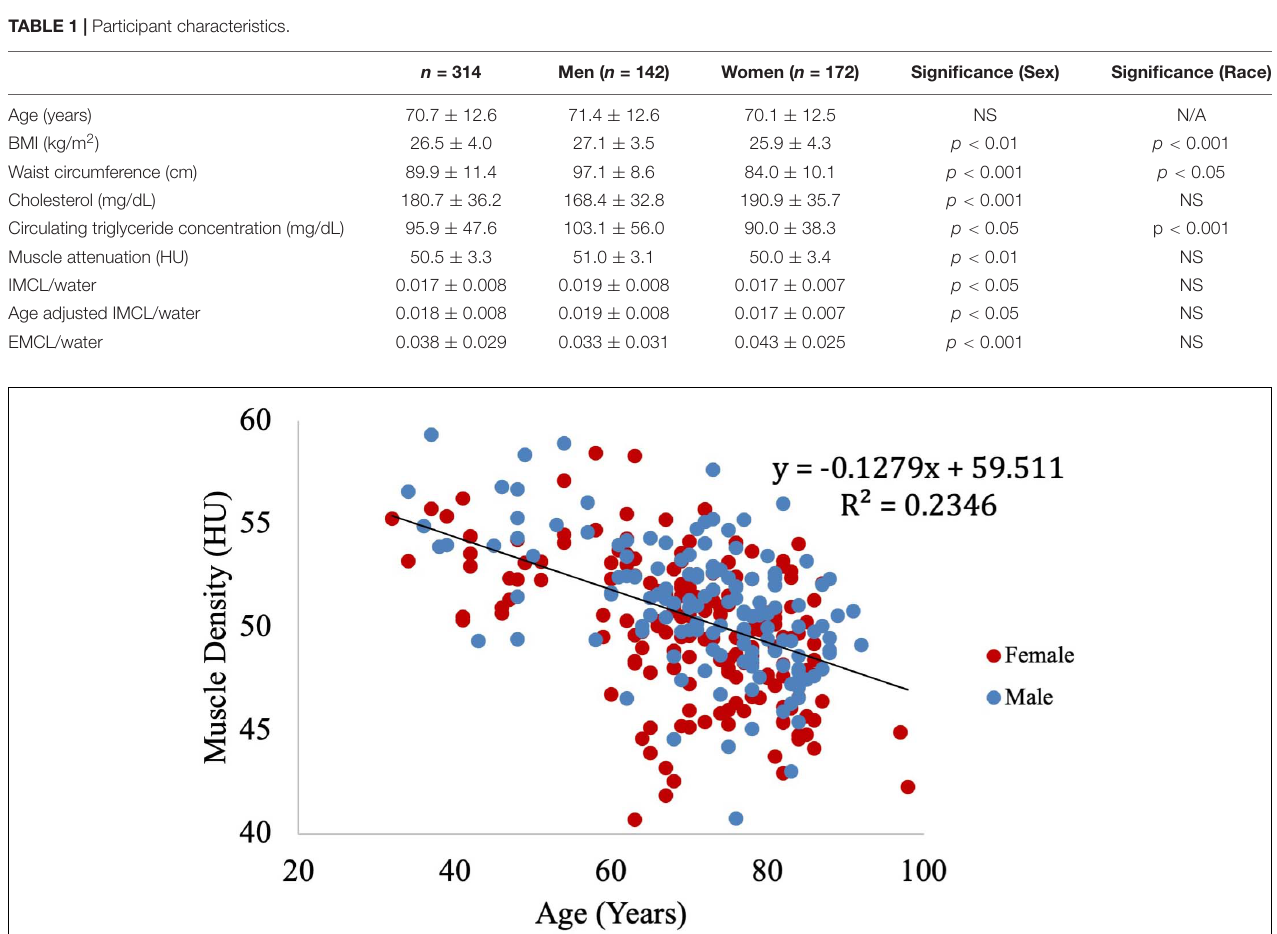
FIGURE 3 | Relationship between muscle density from CT and age. As expected, muscle density decreases significantly with age ( p <